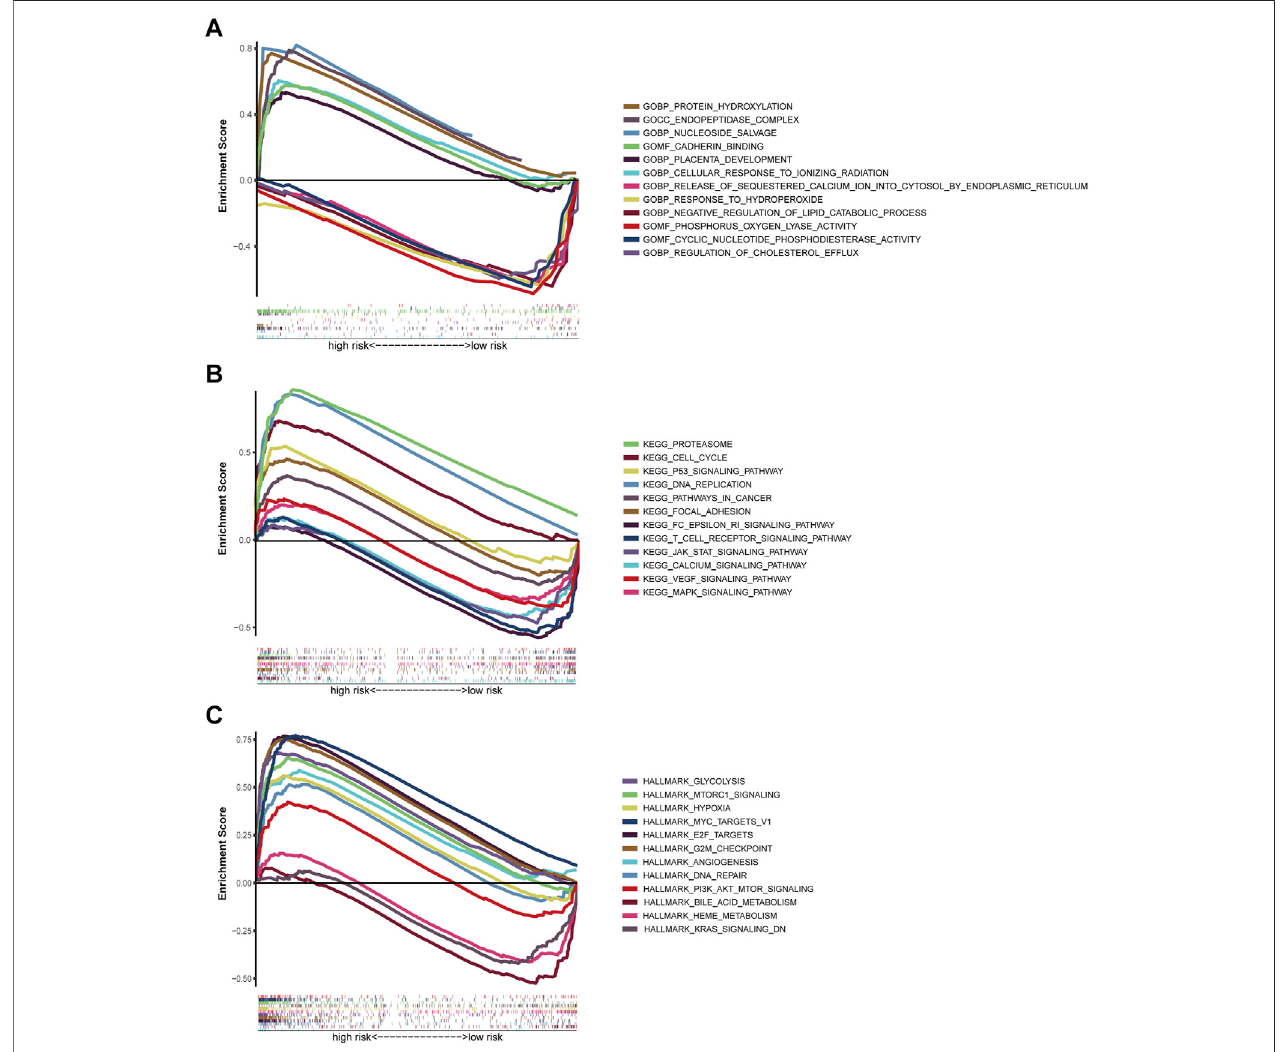
FIGURE 8 | Gene set enrichment analysis of Biological functions and pathways. (A) GO, Gene Ontology. (B) KEGG, Kyoto Encyclopedia of Genes and Genomes. (C) Hallmark gene set.